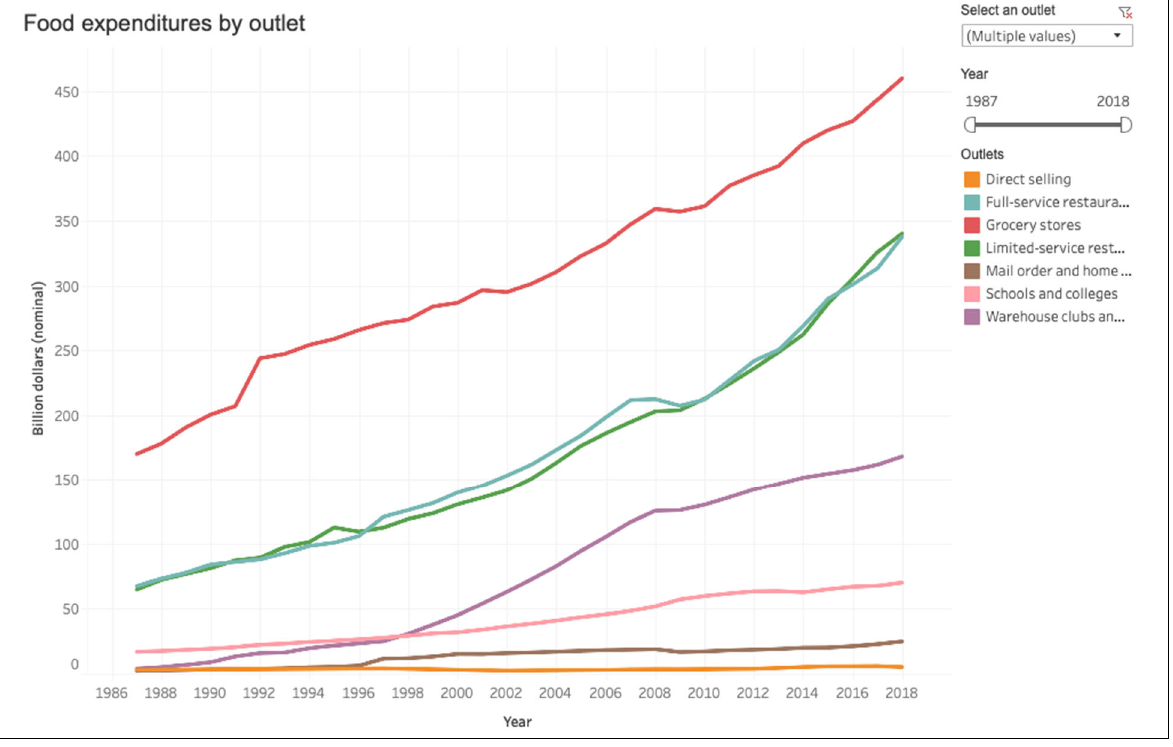
Source: U.S. Department of Agriculture Economic Research Service